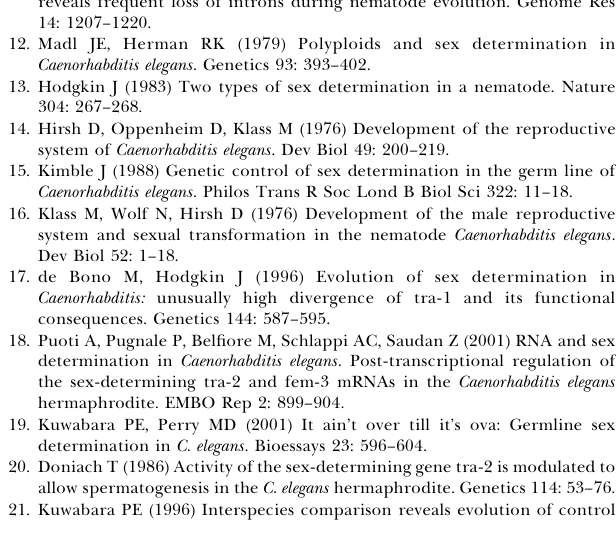
Figure S1. Phylogenetic Relationships of 30 C. elegans and C. briggsae FTR Genes Closely Related to FOG-2 Presented as a Rectangular Phylogram